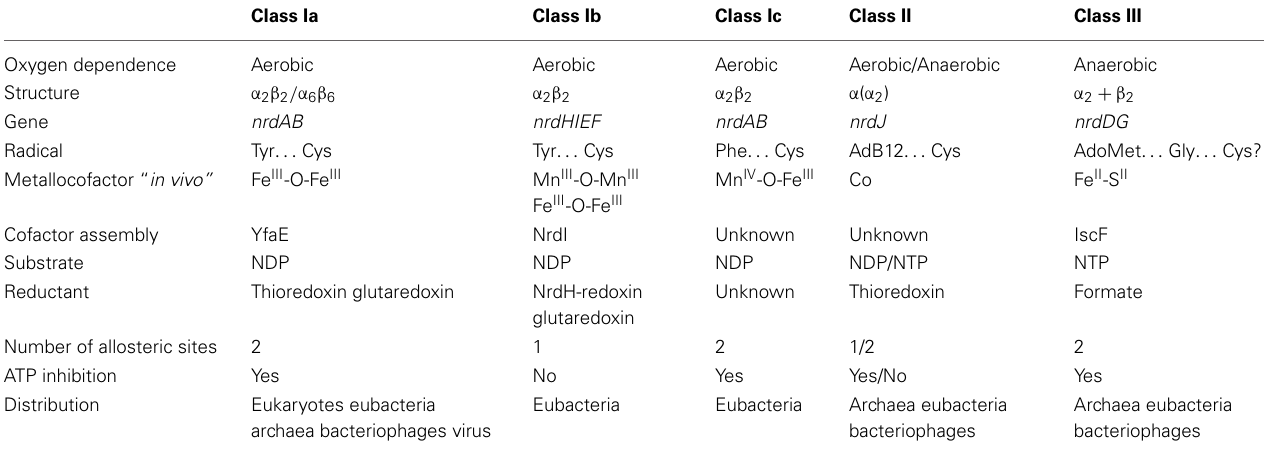
Table 1 | Overview of RNR